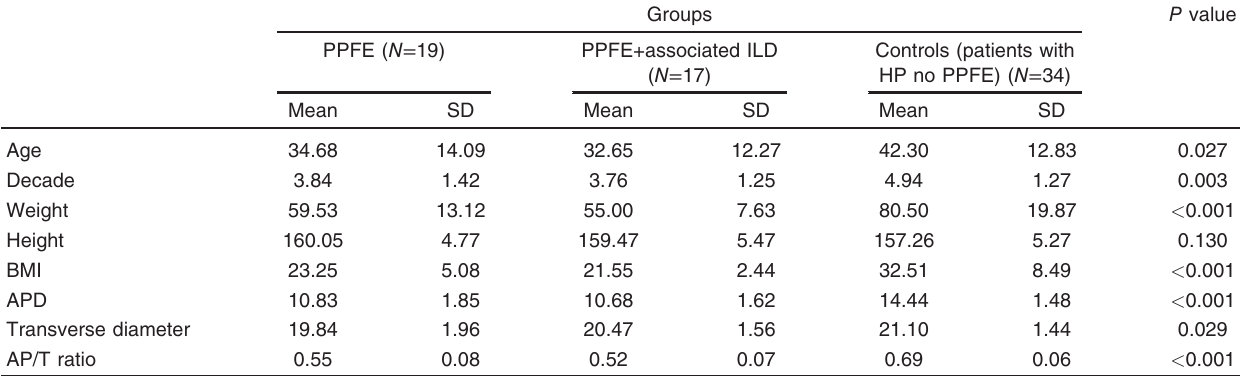
Table 1 Correlation between study population groups regarding demographics and chest wall measurements